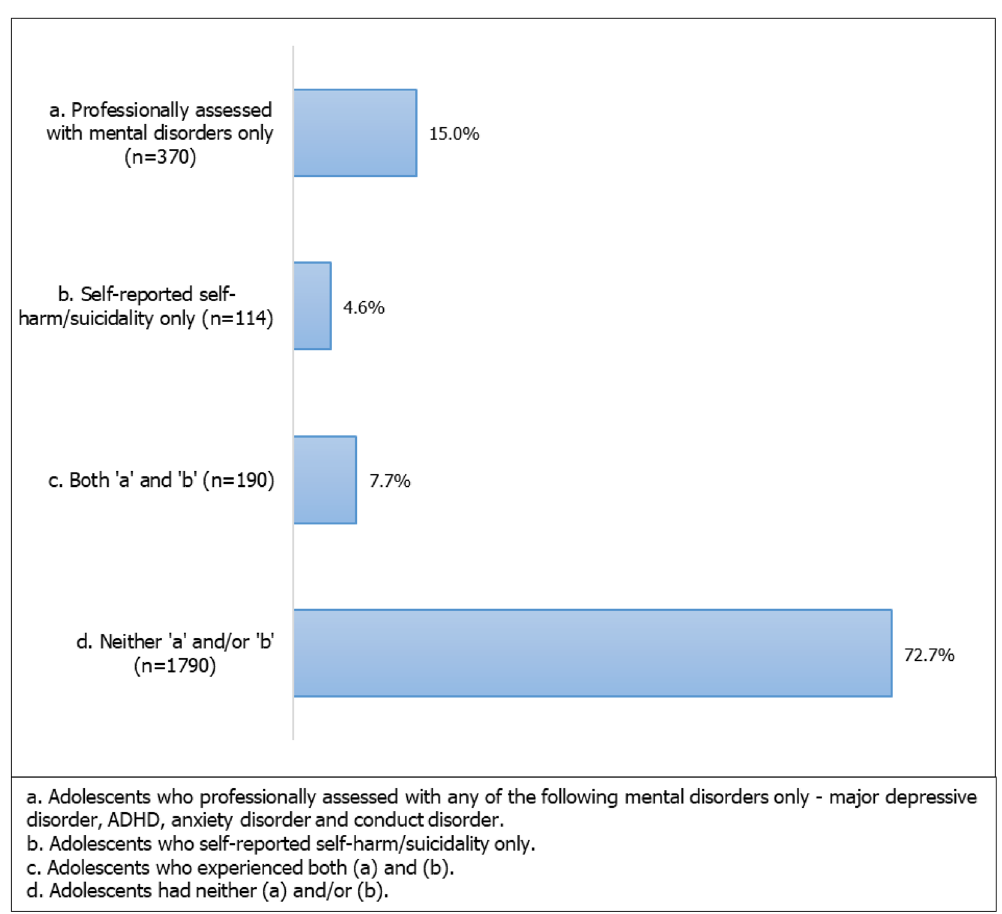
Figure 2. Prevalence of mental health problems.